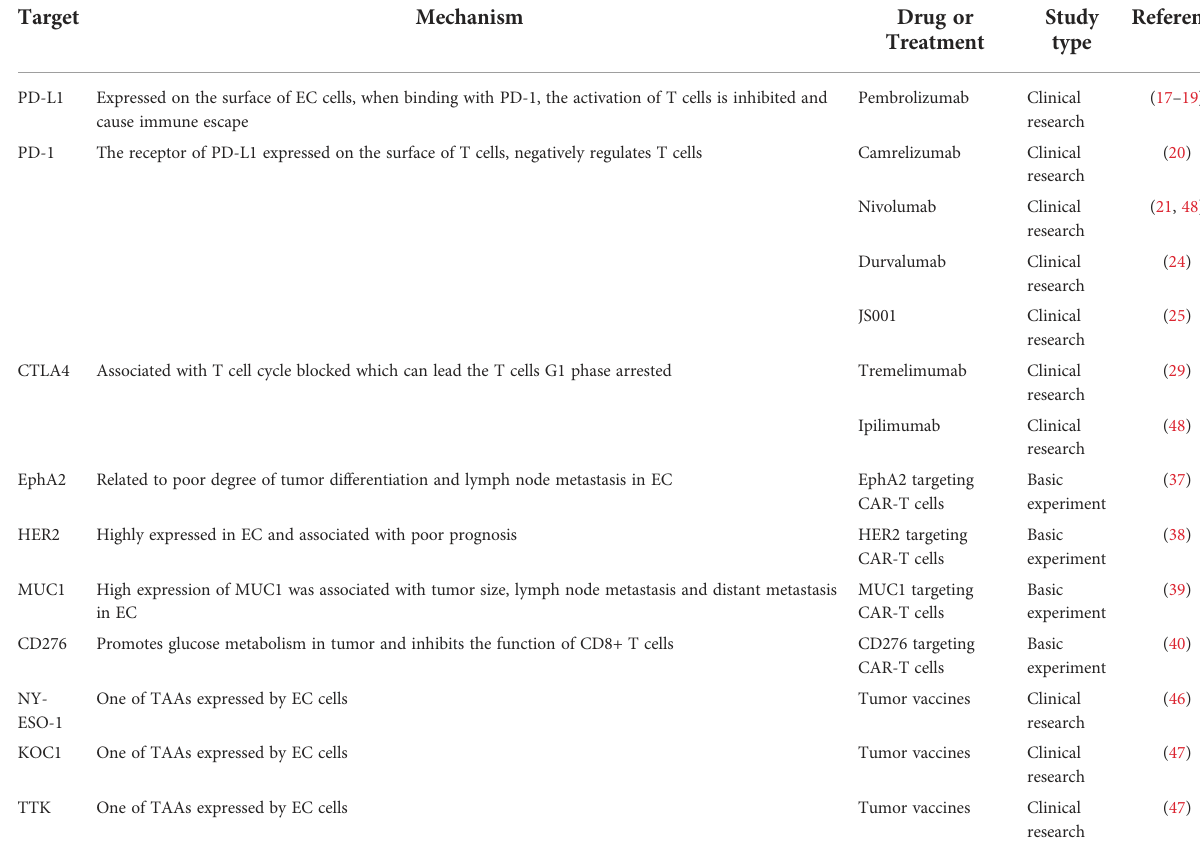
TABLE 1 Current advancements in immunotherapy for